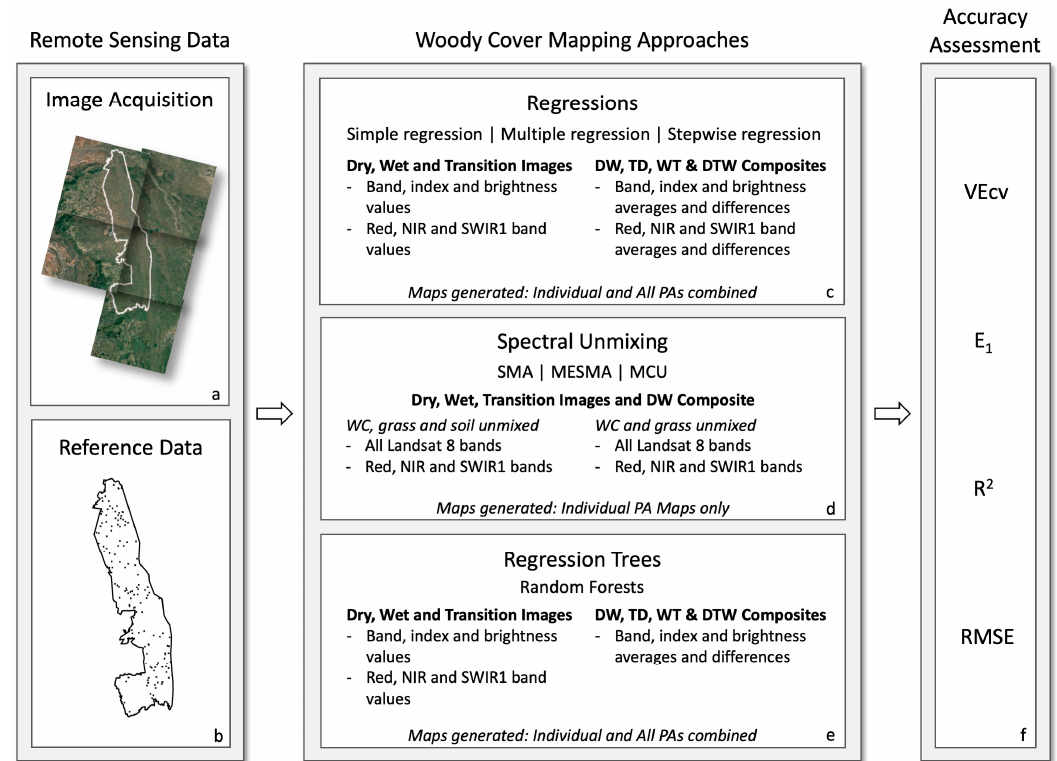
3. Figure 3. Conceptual diagram of methodology. For each PA, we collected, processed, and downloaded Landsat imagery from the dry, wet, and transition seasons using Google Earth Engine (GEE) ( a ). We then extracted band and index values at reference points throughout each PA and used very high-resolution (VHR) imagery available through Google Earth to map the woody cover (WC) at each point ( b ). These data, which varied across single and combined season imagery, were used to create WC maps of the individual PAs using regression, spectral unmixing and regression trees ( c – e ). In addition, the reference data from all the PAs (ALL) were pooled to generate another series of Random Forest (RF)- and regression-derived maps. We assessed the accuracy of the maps using VEcv, E 1 , R 2 , and RMSE ( f ). SMA: spectral mixture analysis; MESMA: multiple endmember spectral mixture analysis; MCU: Monte Carlo